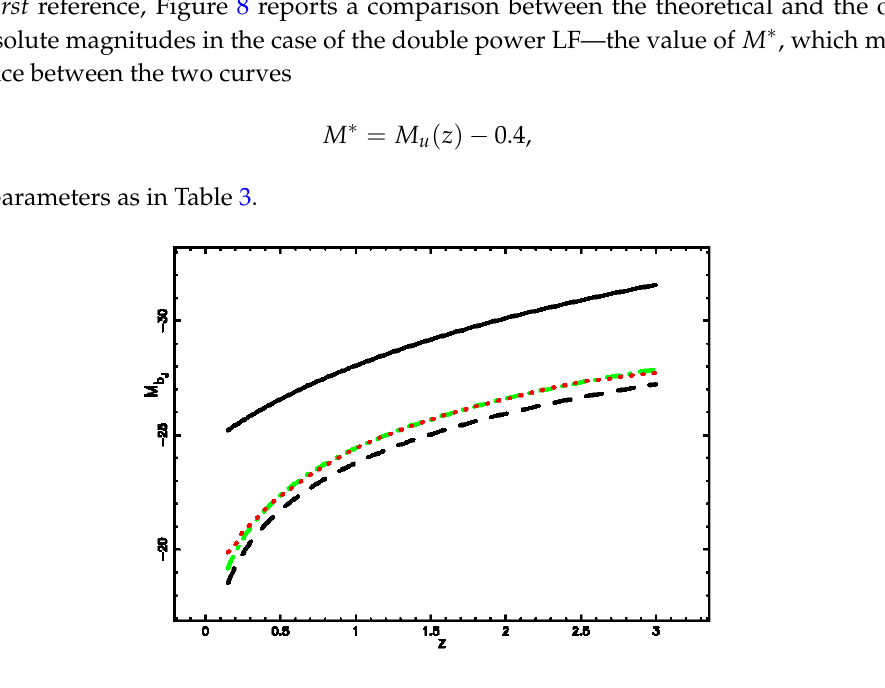
Figure 8. Average observed absolute magnitude versus redshift for QSOs (red points), average theoretical absolute magnitude for the double power LF as evaluated numerically (dot-dash-dot green line), theoretical curve for the empirical lowest absolute magnitude at a given redshift, see Equation (42) (full black line) and the theoretical curve for the highest absolute magnitude at a given redshift (dashed black line), see Equation (37), RSS =